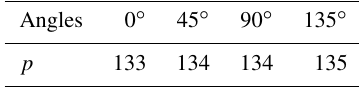
Table 1. The number of pixels along the diameter.